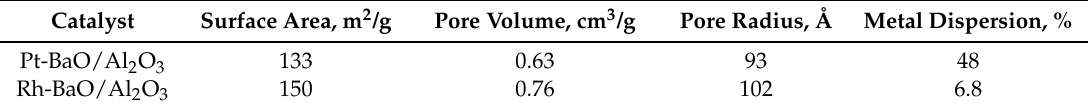
Table 1. Morphological characterization of